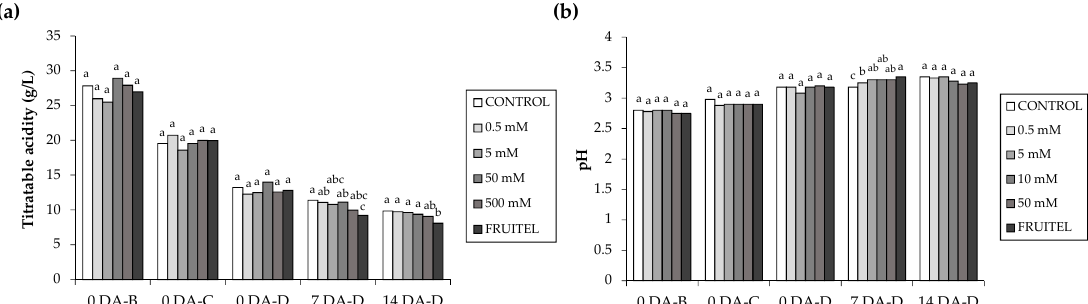
Figure 5. Acid content evolution of Vitis vinifera L. cv Alicante Bouschet berries of non-treated (CONTROL) plants, HB weekly-treated plants at different concentrations (0.5, 5, 10, 50 mM) and plants treated with FRUITEL. ( a ) Changes in total acidity content and ( b ) pH of berries of non-treated, HB-treated and FRUITEL-treated plants. An ANOVA test was performed, and different letters indicate statistical significances with a p -value < 0.05.